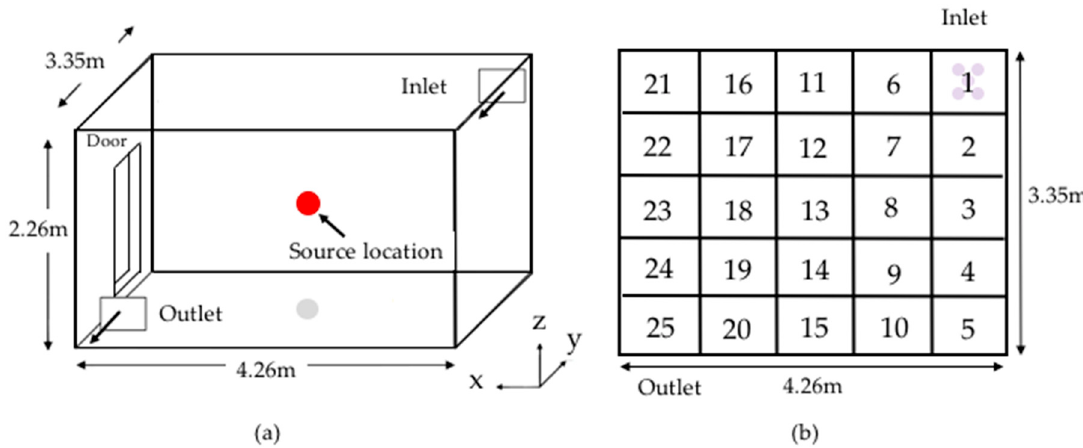
Figure 1. ( a ) Empty chamber geometry indicating ventilation and aerosol release location; ( b ) Zone location on floor of empty chamber with representative Petri dish arrangement in zone 1.